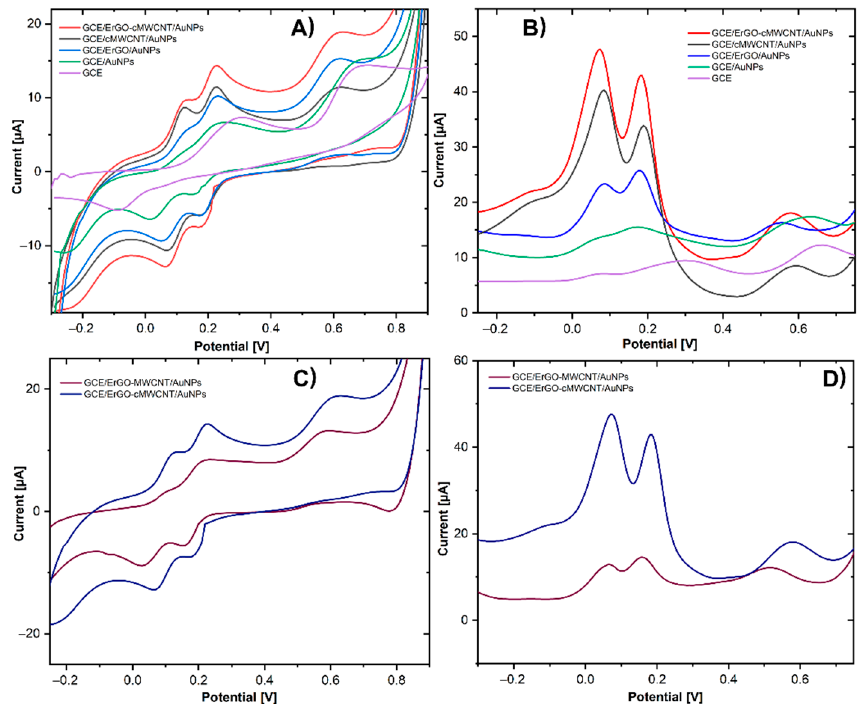
Figure 5. ( A , C ): Cyclic voltammetry of modified GCE electrodes in HQ, CC, and RS 0.2 mM in PBS 0.01 M at pH 7. ( B , D ): Differential pulse voltammetry of modified GCE electrodes in HQ, CC, and 0.01 M at pH 7. ( B , D ) Differential pulse voltammetry of modified GCE electrodes in HQ, CC, and RS RS 0.2 mM in PBS 0.01 M at pH 7. 0.2 mM in PBS 0.01 M at pH